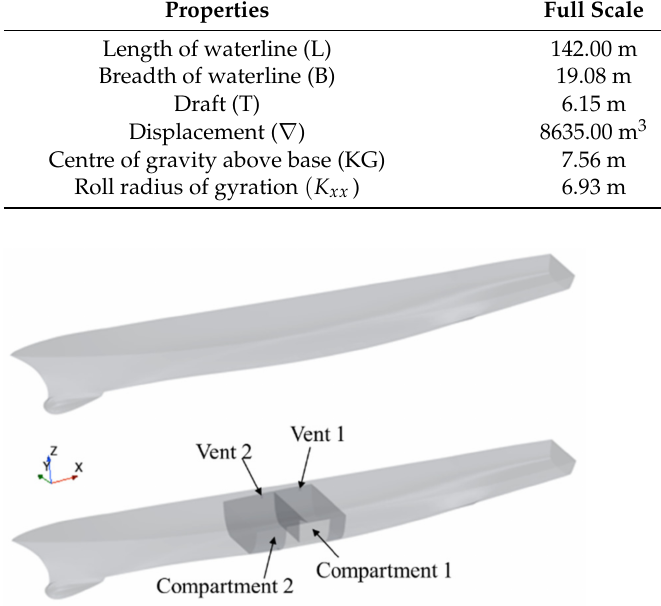
Figure 4. Geometry of DTMB 5415 ship model in intact and damaged